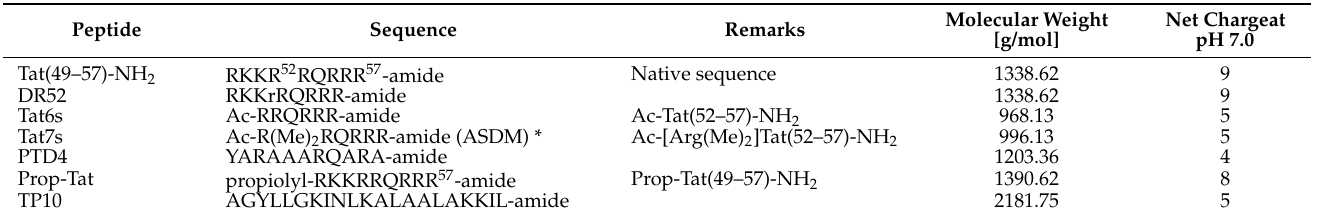
Table 1. Physicochemical properties of peptides studied (* asymmetrical dimethylation).